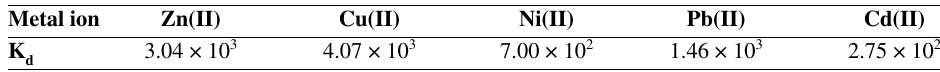
Table 3. Distribution coefficients for the studied metal species.